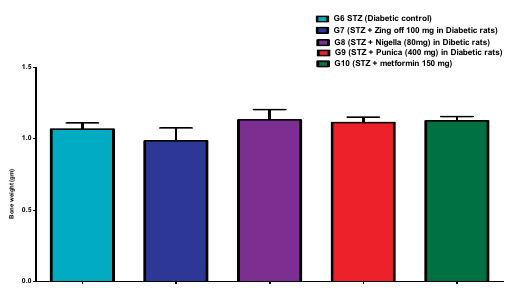
Fig. 3. Comparison of the bone weight (gram) in different studied groups.